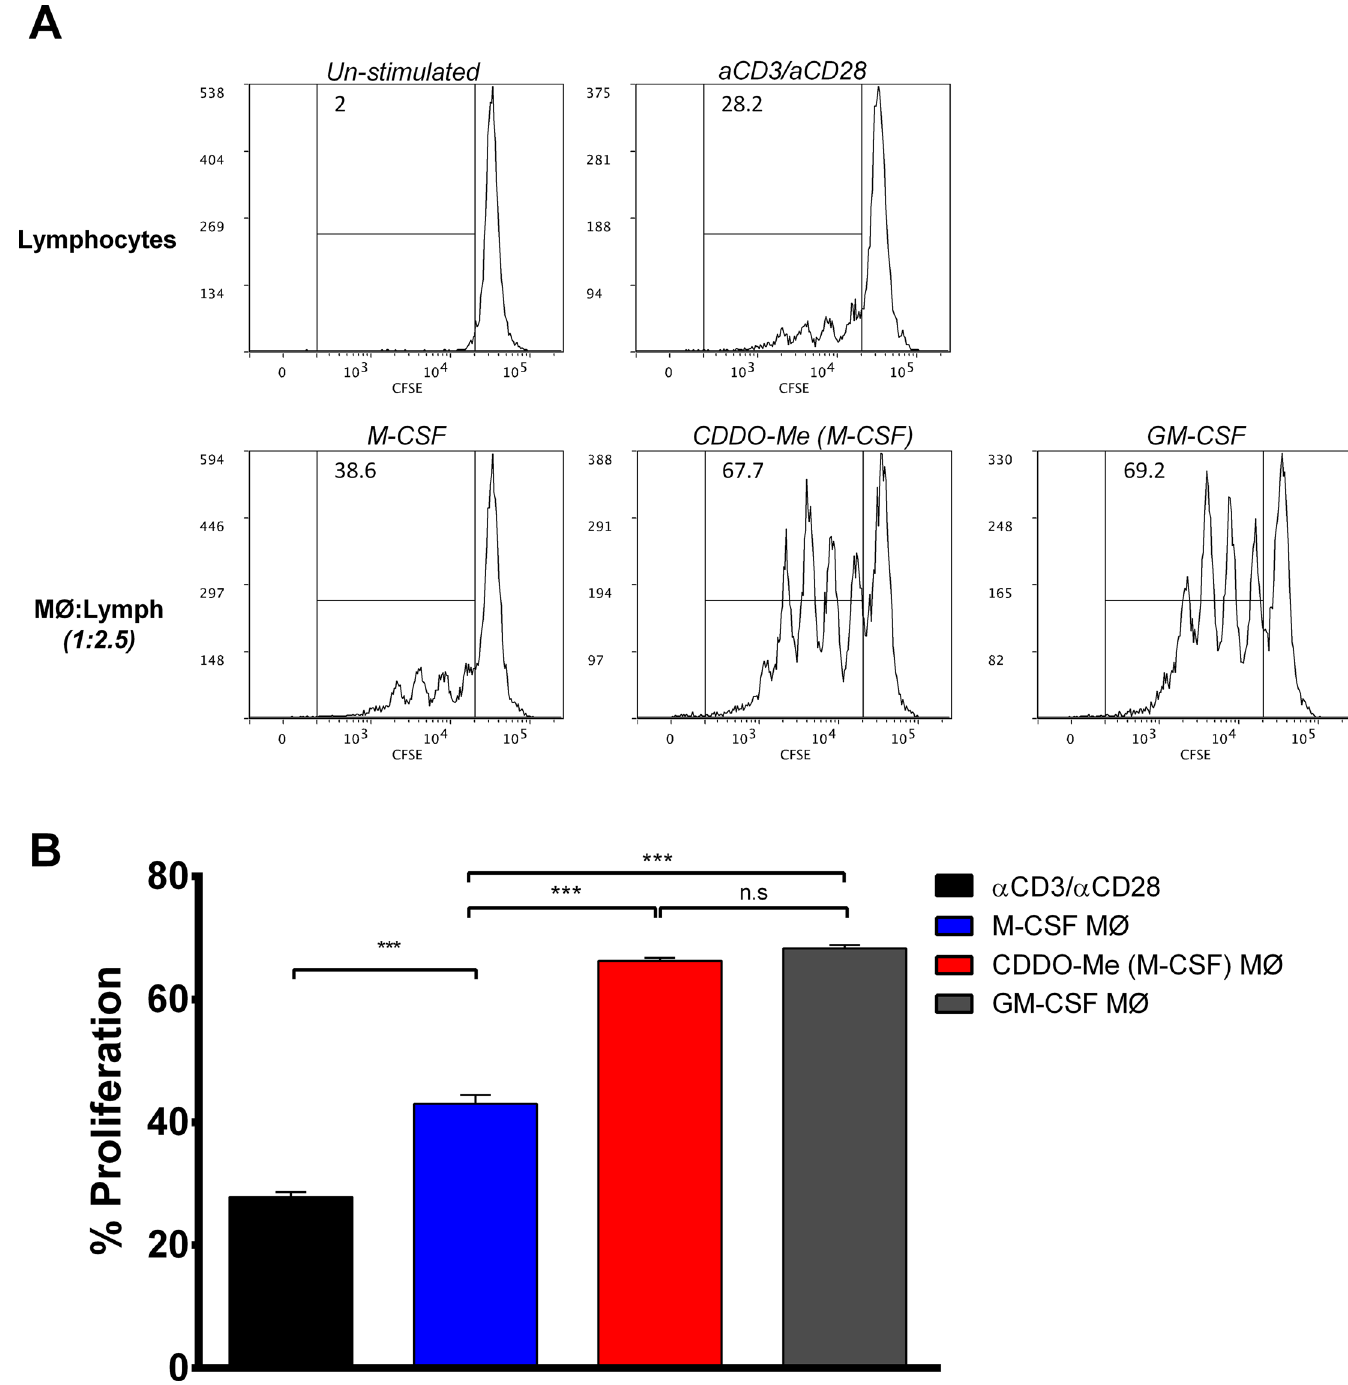
Fig 3. CDDO-Me treatment enhances the ability of M2 macrophages to induce T cell proliferation. (A) Representative histograms of CFSE proliferation assay. Top panels show un-stimulated and stimulated ( α CD3/ α CD28) T cell proliferation in media alone. In bottom panels, macrophages were differentiated with GM-CSF to generate M1 macrophages or M-CSF to elicit M2 macrophages. M2 macrophages were treated +/- CDDO-Me for 16 hrs followed by LPS stimulation for 24 hours and co-cultured with autologous T cells. T cell proliferation was measured by CFSE dilution using flow cytometry. (B) Graphical depiction of representative CFSE experiment. Data are representative of results obtained from 3 independent proliferation assays, and 3 technical replicates were analyzed in each assay. *** p < 0.005; biological replicates, n = 2.